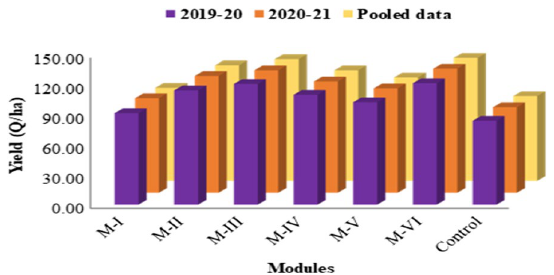
Fig. 5 Effect of different modules on yield of